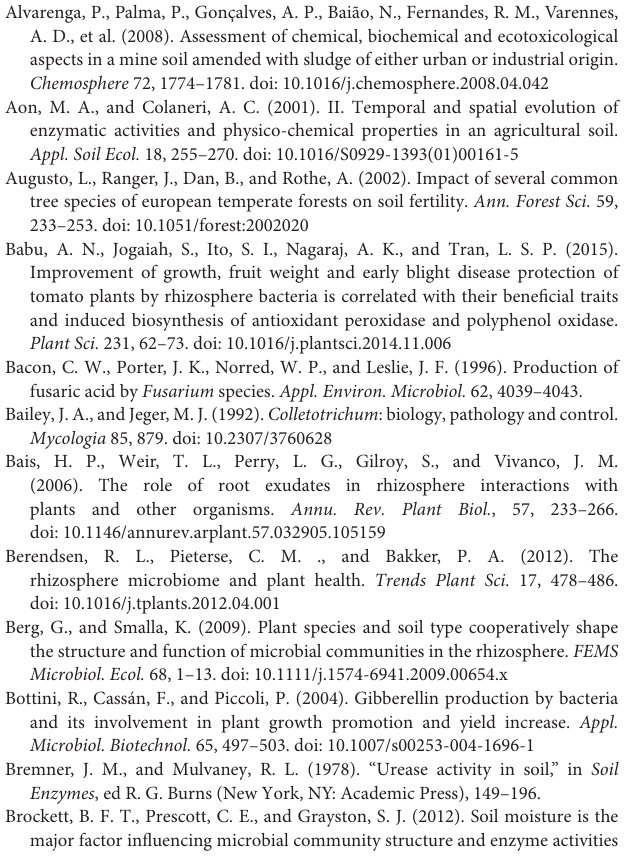
Table S1 | Sequencing data details of bacterial communities. Table S2 | Sequencing data details of fungal communities. Table S3 | Rhizosphere soil trace element content of different deciduous fruit trees. Table S4 | Pearson correlation coefficients between of soil enzymes and environmental factors.